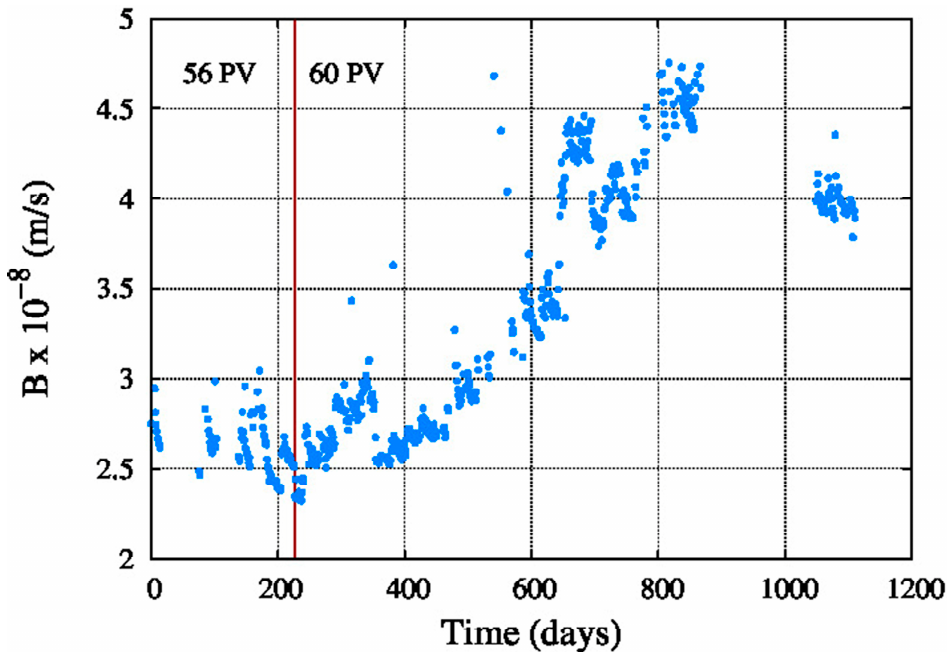
Figure 10. Average salt permeability coefficient.